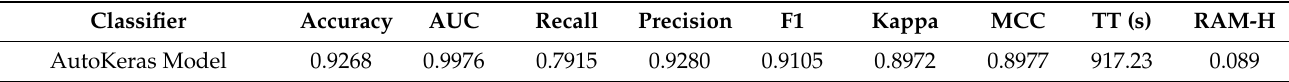
Figure 6. Depiction of the AutoKeras model. Table 4. Classification performance metrics of the AutoKeras